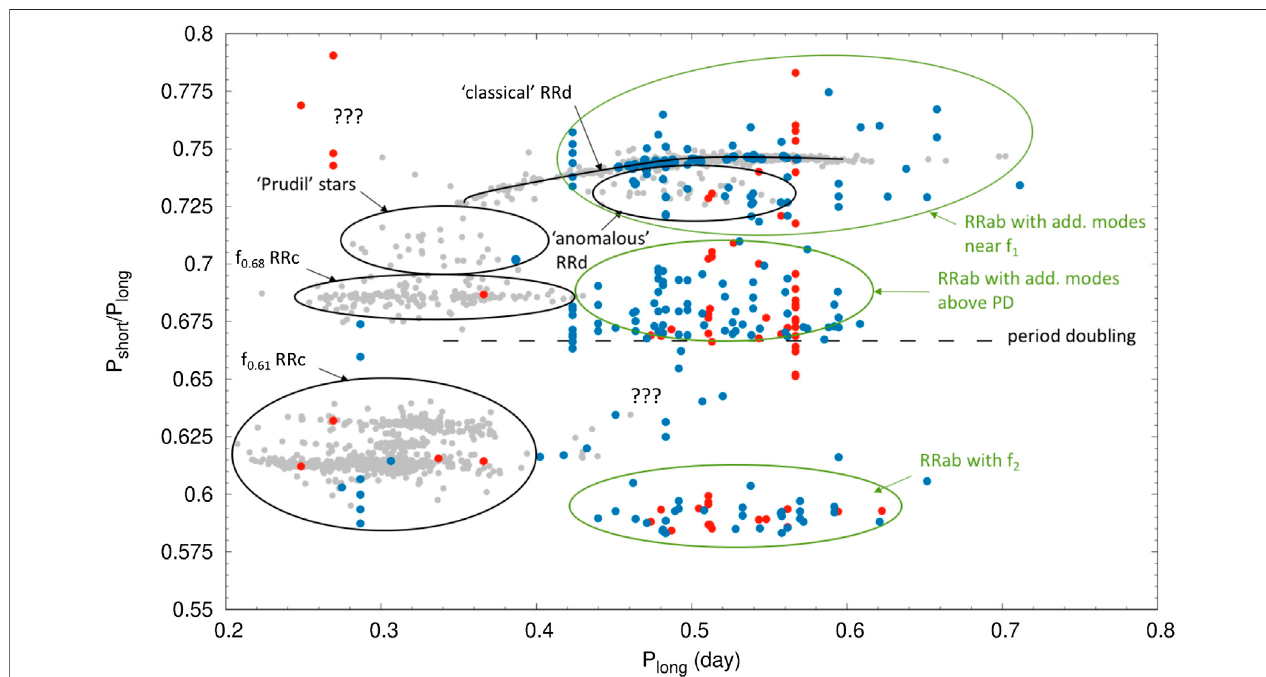
FIGURE 8 | Petersen diagram of multimode RR Lyrae stars. The gray points denote OGLE discoveries collected (Soszy´nski et al., 2016a; Soszy´nski et al., 2016b; Prudiletal.,2017;NetzelandSmolec,2019;Soszy´nskietal.,2019).Redpointsareresultsfromthe Kepler fi eld(Benk ő etal.,2014;Moskaliketal.,2015)andbluepoints from the K2 mission (Molnár et al., 2017b; Moskalik et al., 2018; Plachy et al., 2019).